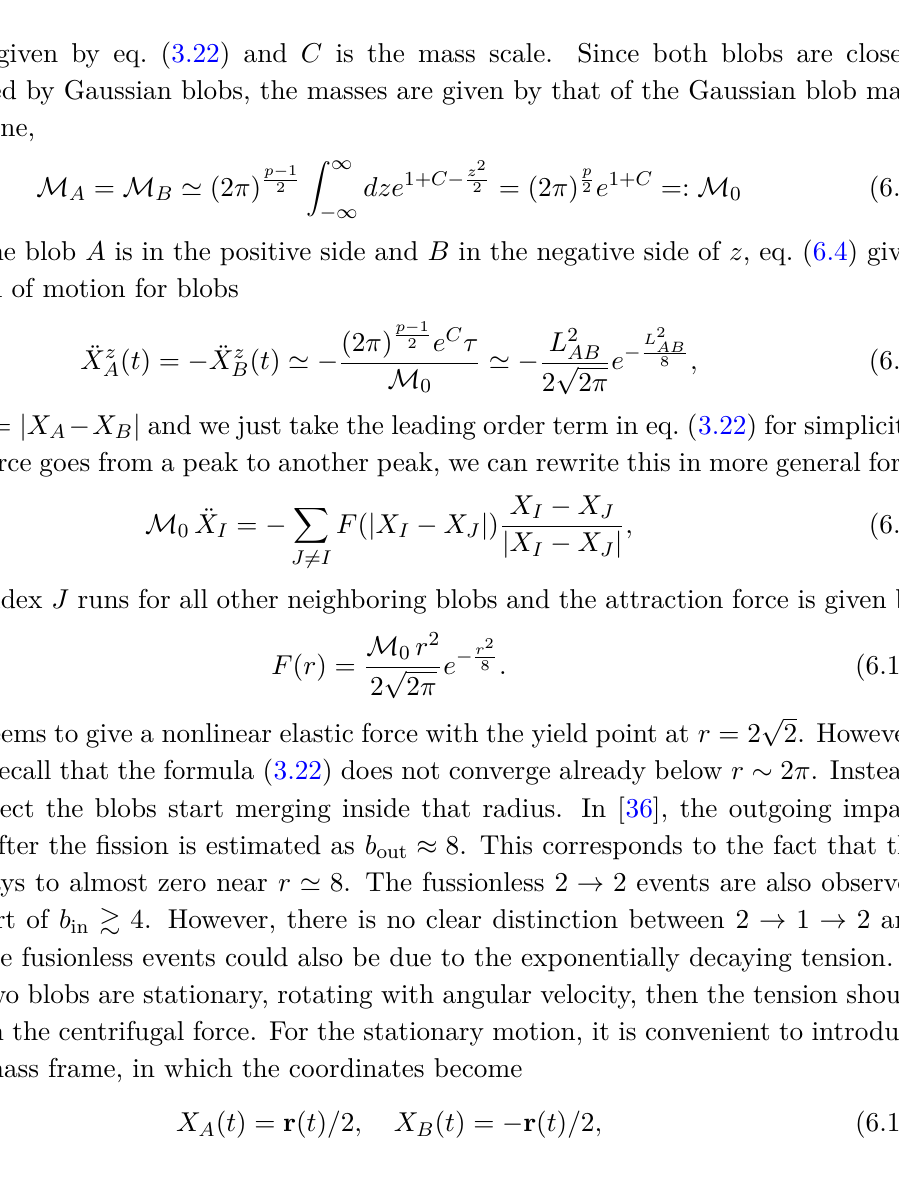
Figure 13 . Interaction between two equal mass blobs. The dominant contribution of the boundary integral comes from the tension on the neck waist (red region), whose cross section (dotted line) is approximated by that of the black string